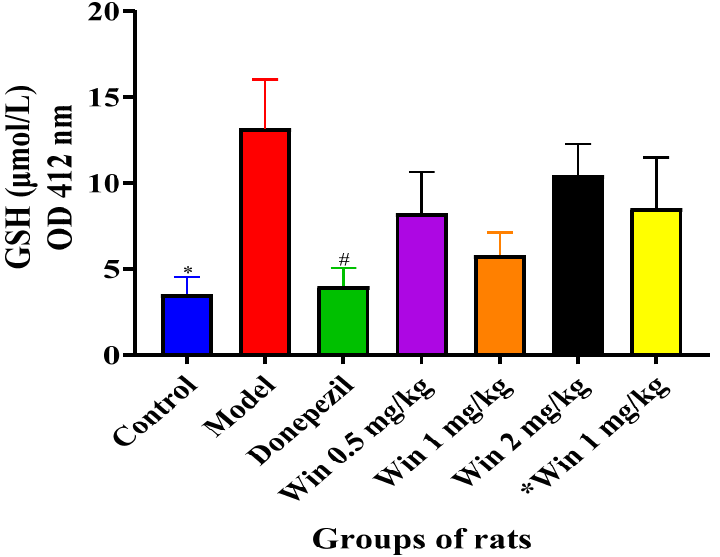
Figure 8. WIN potentially reduced GSH level in the cerebral cortex of D -gal- and AlCl 3- induced rats. Values are presented as mean ± SEM, n = 5. * p < 0.05 vs. model, # p < vs. control.